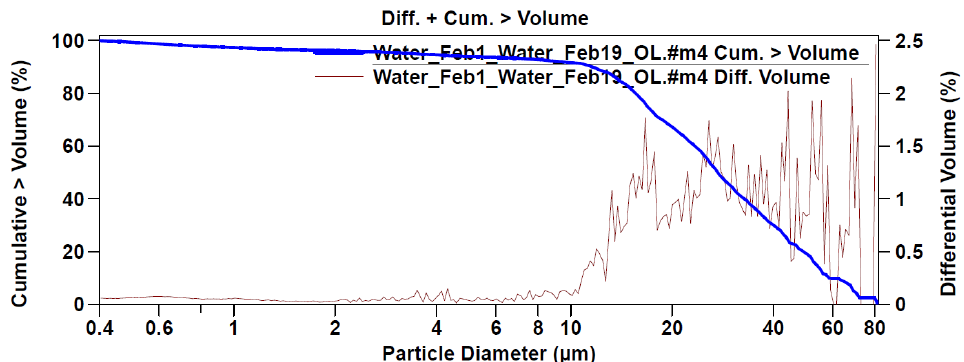
Figure 3. Particle diameter in relation to cumulative volume. Table 1. Statistical data of the tests. All values in µ